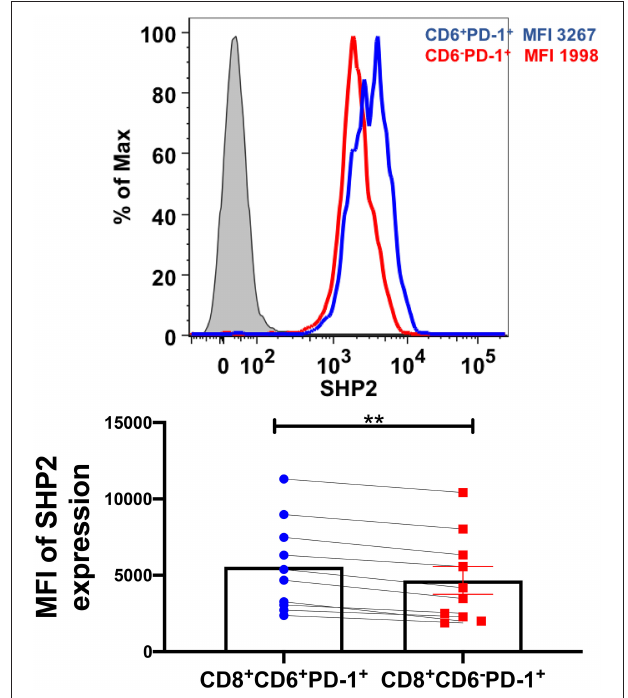
FIGURE 8 | Expression of SHP2 in CD8 + CD6 + PD-1 + T-cells during chronic infection. Representative staining of SHP2 in CD8 + CD6 + PD-1 + and CD8 + CD6 − PD-1 + T-cells from chronically-infected macaques in the spleen. Median fluorescence intensity (MFI) of SHP2 in CD8 + CD6 + PD-1 + and CD8 + CD6 − PD-1 + T-cells (bottom panels). Data are from 10 macaques. Data are shown as means ± SEM. For statistical analysis, Mann-Whitney tests were performed. ** p <